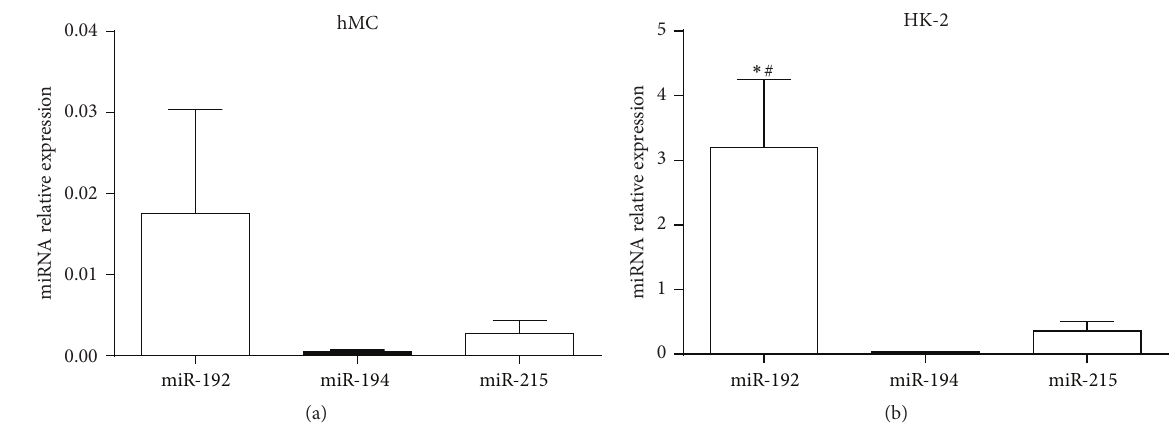
Figure 6: Comparison of the relative expression of miR-192, miR-194, and miR-215 in EVs from cellular supernatants from both the NG and HG groups. ∗ The level of EV miRNA-192 compared with miR-194 ( 𝑃 < 0.05 ). # The level of EV miR-192 compared with miR-215 ( 𝑃 < 0.05 ) (a) from hMCs and (b) from HK-2 cells. MiRNA levels were normalized to cel-miR-39 and calculated using the 2 −Δ CT method. Data are presented as the mean ±